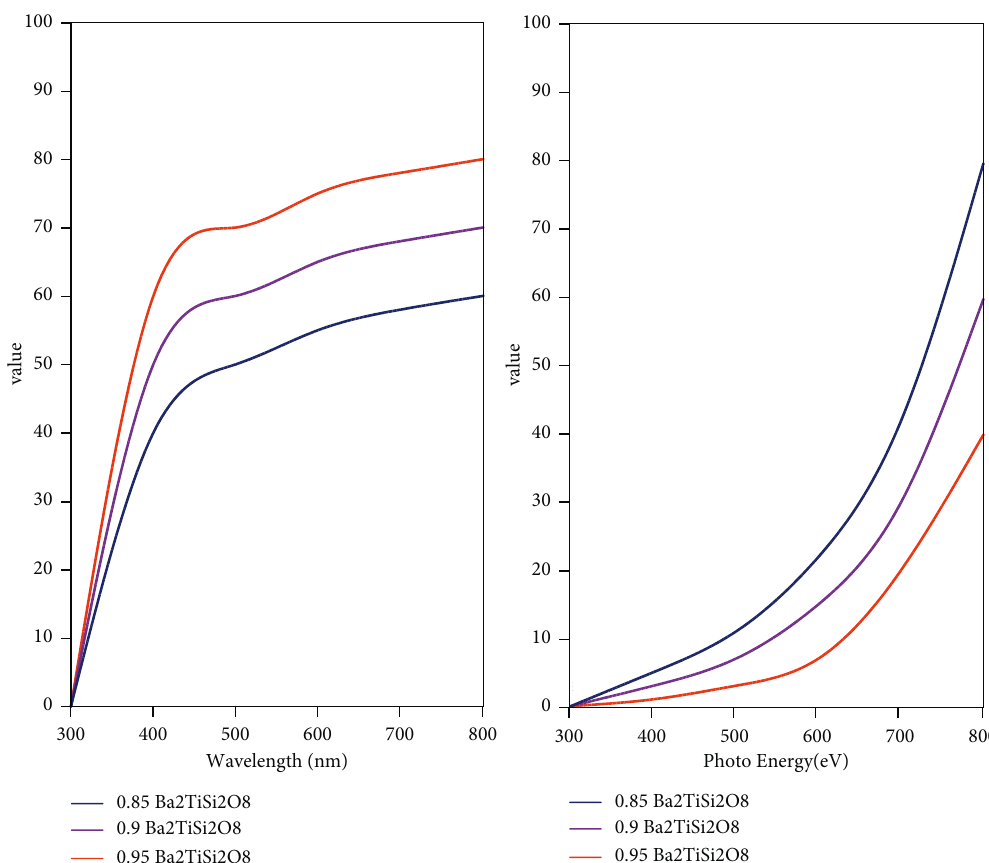
Figure 4: The fitting of transmission spectrum and optical band gap of Ba